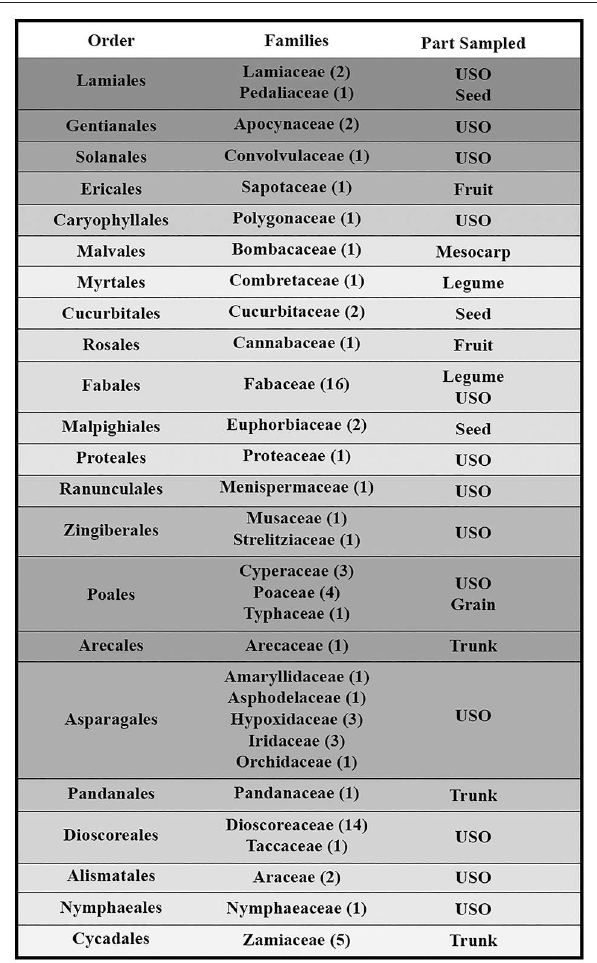
lineage, presented in phylogenetic order from primitive to derived ( Figure 1 ). Selection followed ethnobotanical criteria in three African ecoregions: the Guineo-Congolian, Zambezian, and Somalia-Masai